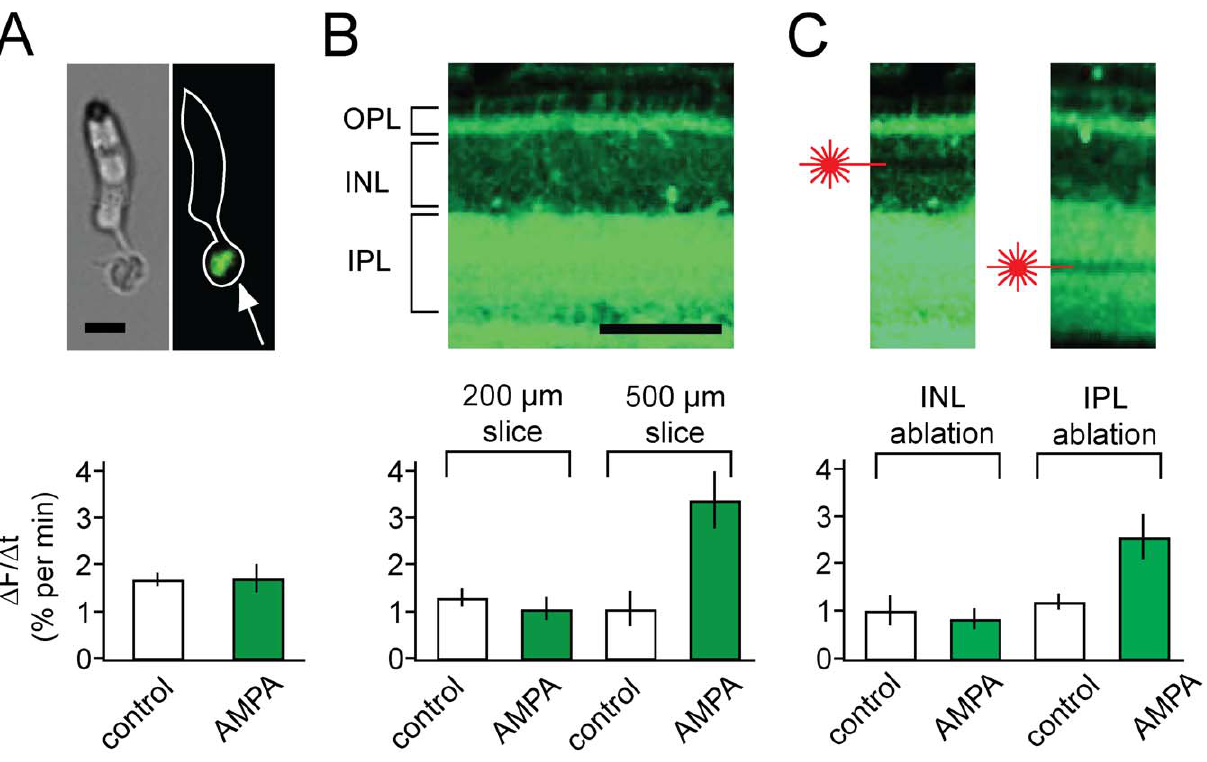
Figure 3. Determining the cellular locus of AMPA-accelerated release. (A) AMPA has no effect on release from isolated cones. Top: Images of a dissociated cone photoreceptor from a FM1-43 loaded anole retina; brightfield (left), fluorescence (center), and overlay of both images (right). Dye fluorescence is localized to the synaptic terminal (arrow). Scale bar = 10 m m. Bottom: Release rate from cones in 20 m M AMPA ( n =6) is the same as in control cones without AMPA ( n =6). (B) AMPA accelerates release in thick, but not thin, retinal slices. Top: Fluorescence image of a retinal slice, loaded with FM1-43 prior to slicing. Bottom: 20 m M AMPA has no effect on release in thin (200 m m) slices ( n =9) but accelerates release by , 2.5-fold in thick (500 m m) slices ( n =10). (C) Specific laser ablation of the HC layer disrupts AMPA-accelerated release. Top: Fluorescence image of a 500 m m-thick slice after laser ablation of either the region of the INL containing HC bodies (left) or the center of the IPL containing processes of other retinal neurons (right). Bottom: Ablation of the INL ( n =11), but not the IPL ( n =6), disrupts AMPA-induced release. Scale bar = 100 m m in (A) and (B). Laser-ablated regions extend 600 m m laterally along the surface of the slice.